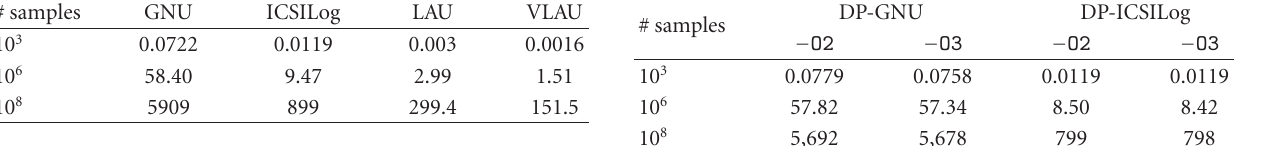
Table 8: Execution times (in ms) of MKL, ICSILog, LAU, and VLAU SP implementations (The icc compiler is used.)